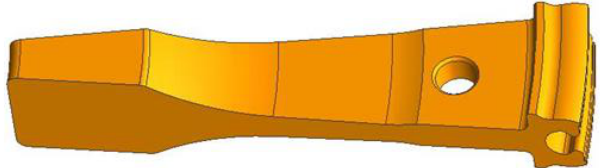
Figure 2. Schematic of the compressor disk (1/36th of the wheel sector).